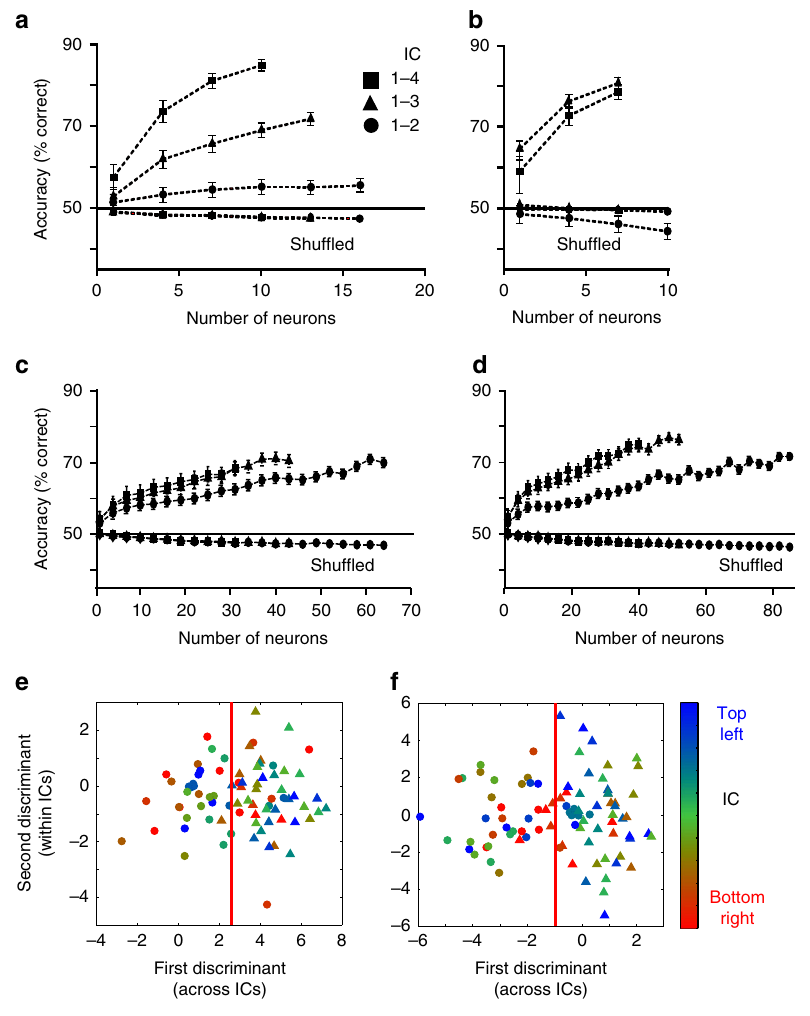
Fig. 4 Bundle decoding. a Support vector machine decoding of bundle distinction between indifference curves (ICs 2 – 4, farther from origin, vs. IC1, closest to origin; z-scored revealed preference responses to bundle stimulus; choice over zero bundle; n = 38 bundles; P < 10 − 20 against the shuf fl ed